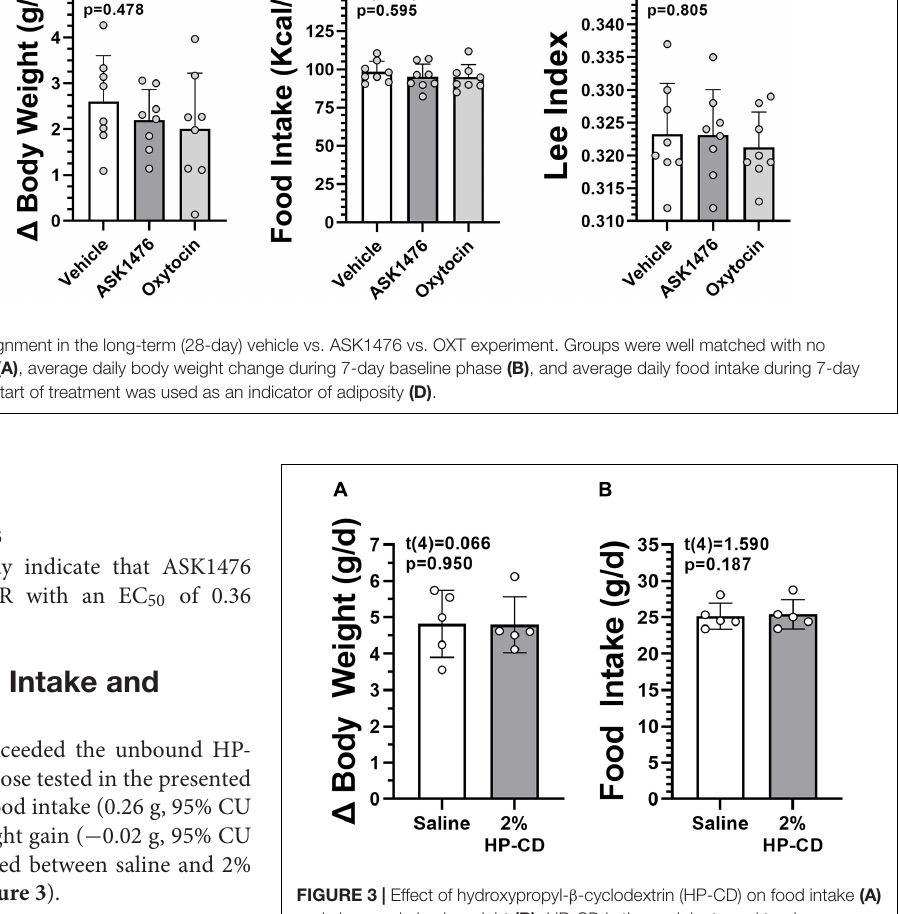
FIGURE 3 | Effect of hydroxypropyl- β -cyclodextrin (HP-CD) on food intake (A) and changes in body weight (B) . HP-CD is the excipient used to place ASK1476 into solution for injection. No effect of treatment was seen during 7-day saline treatment and 7-day 2% HP-CD/saline solution treatment at 1